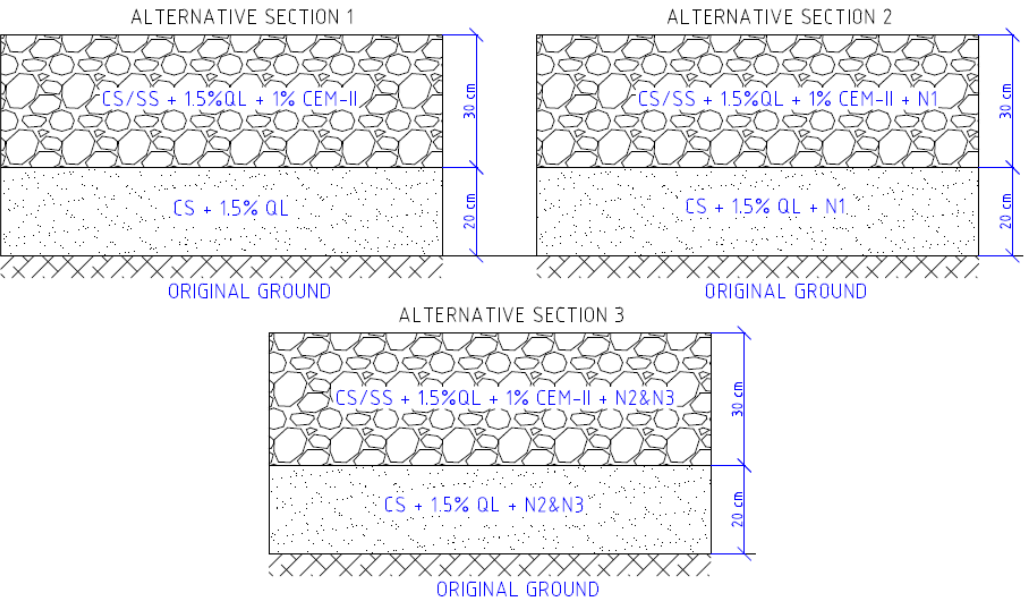
Figure 10. Trial sections scheme.